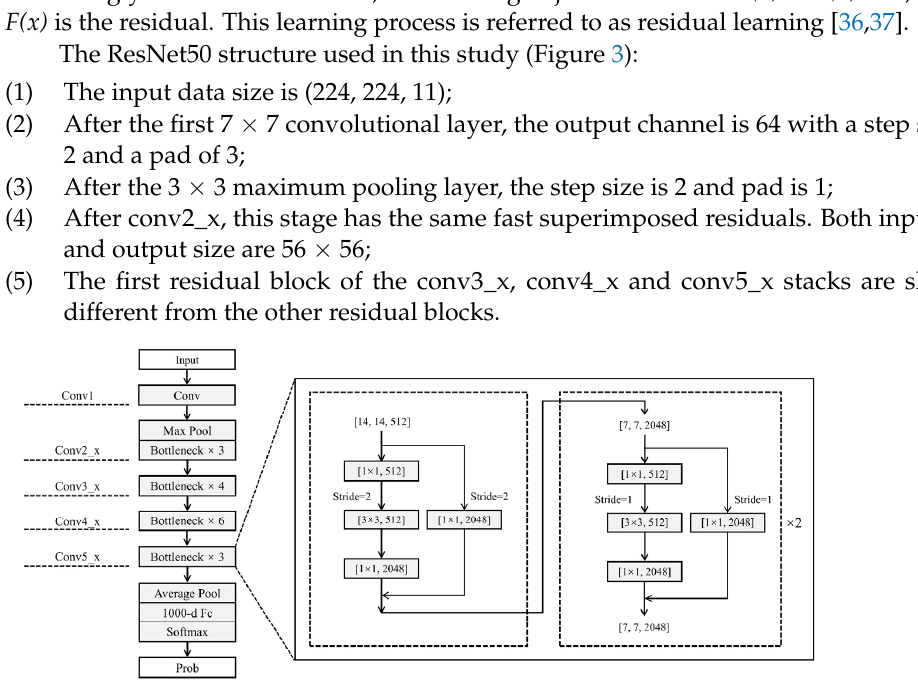
Figure 3. ResNet network